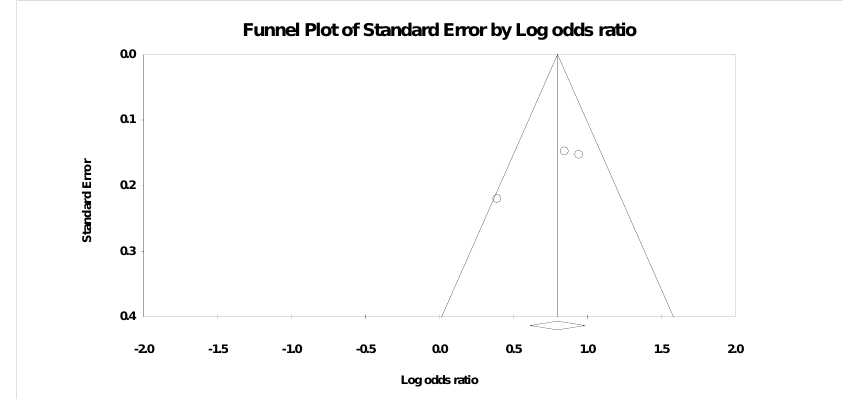
Figure A2. SMS reminder timeliness.